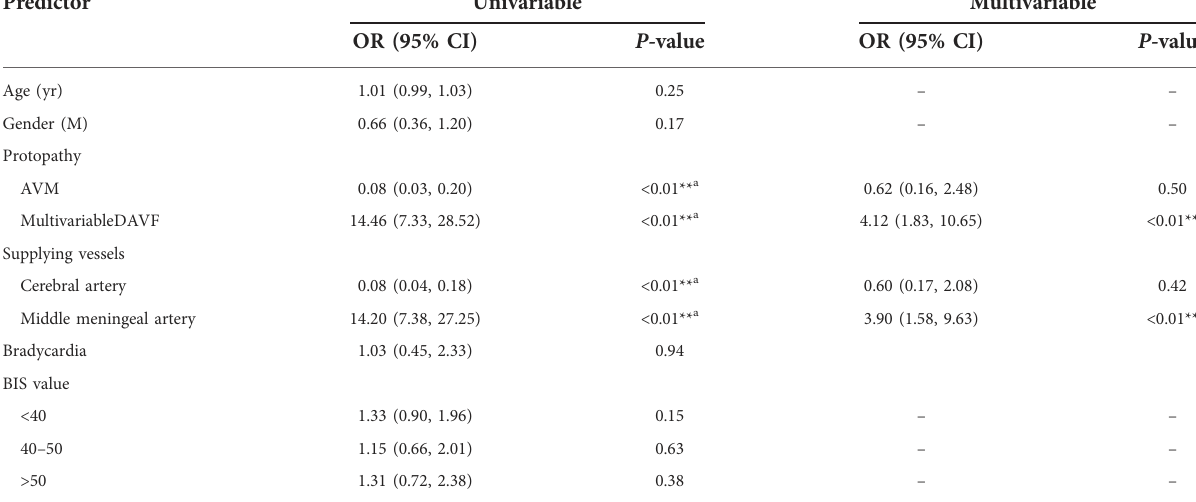
TABLE 2 Univariate and multivariate logistic regression analysis about TCR episode.